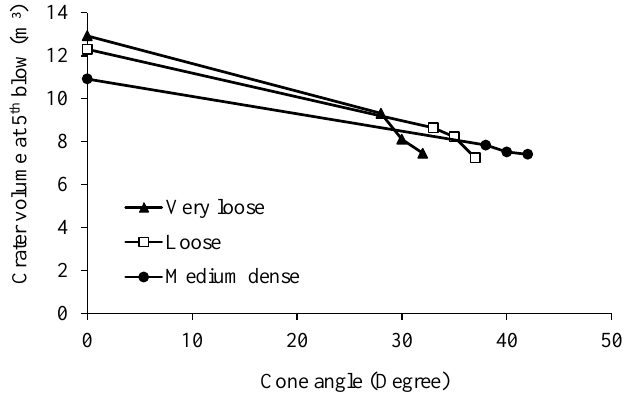
Fig. 8. Variation of crater volume with cone angle in different soil